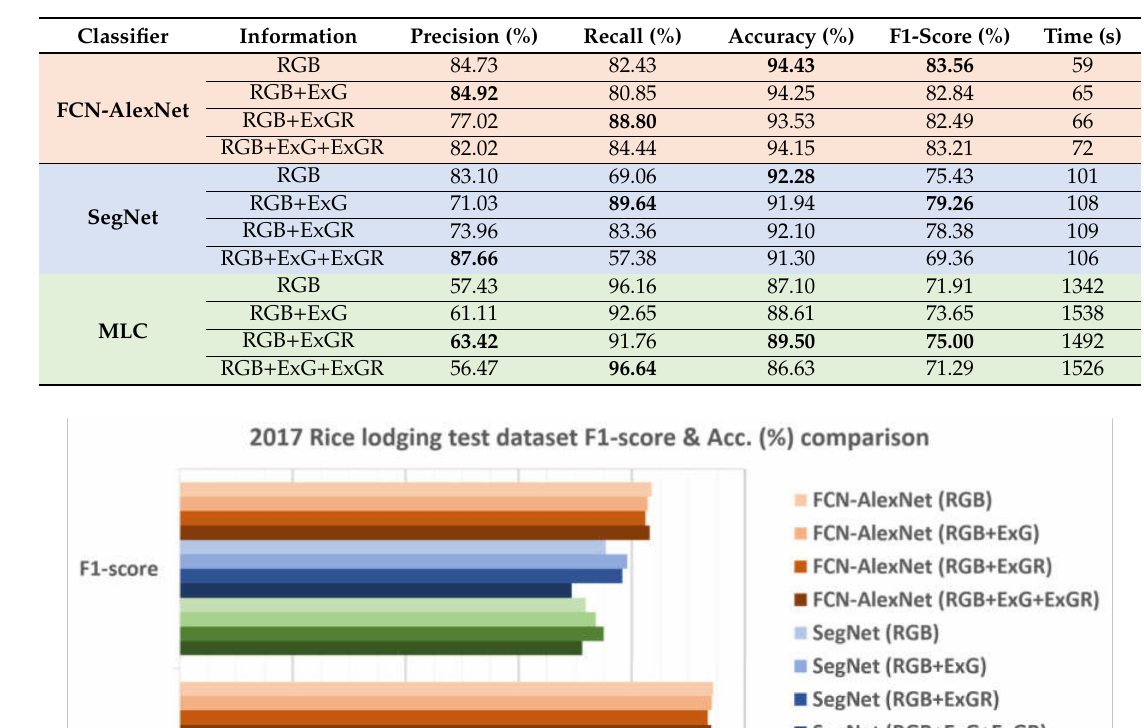
Table 7. Results on the 2017 testing dataset for rice lodging category (the highest value is shown in bold and the colors shadow corresponds to three classifiers in Figures 10 and 11).